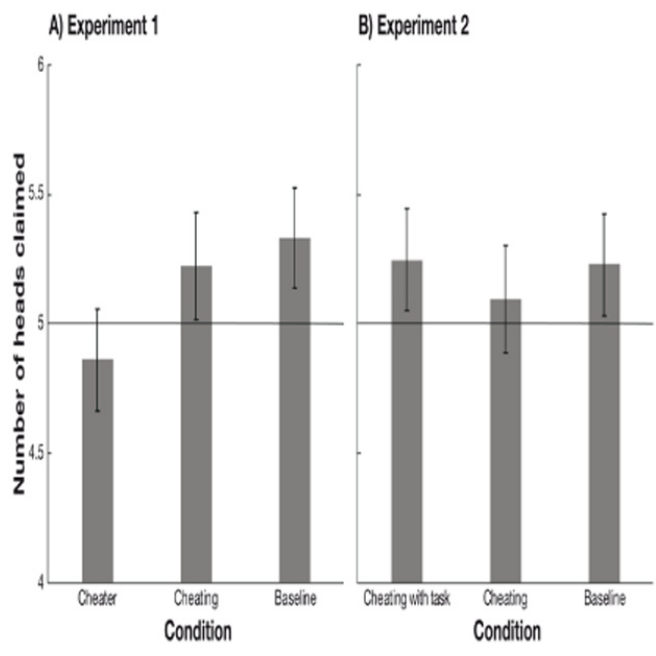
Figure 1. The mean number of “heads” in each instruction condition in Experiment 1 (Panel A ) and Experiment 2 (Panel B ). Error bars indicate 95% confidence intervals of the